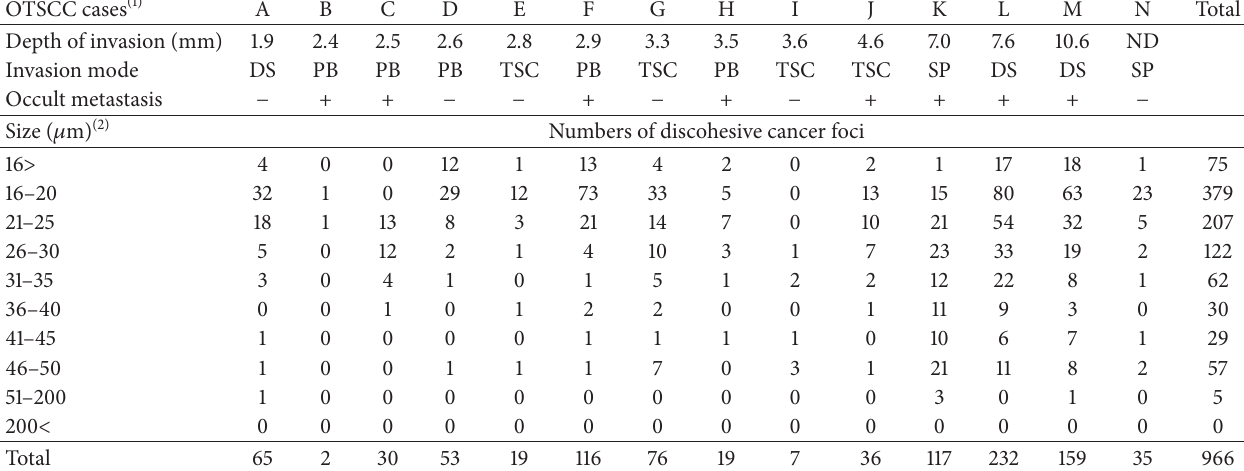
Table 3: Size distribution of discohesive cancer foci segmented at the invasion